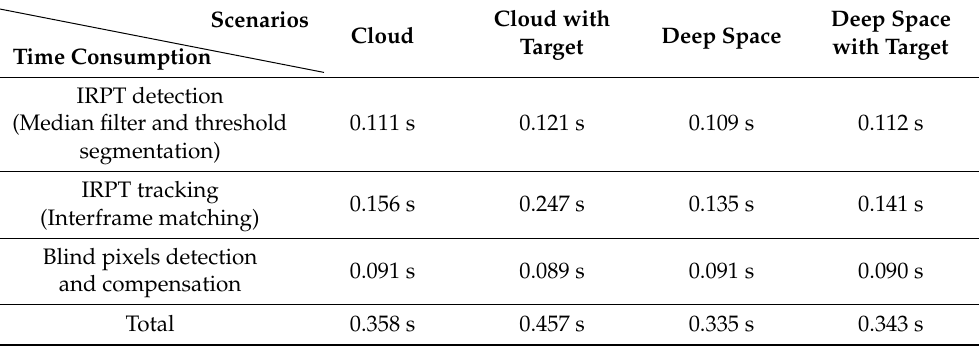
Table 3. The situation of blind pixels detected in four application scenarios. Table 4. The average frame time consumption of each step of our method used in the above experi- ment in different